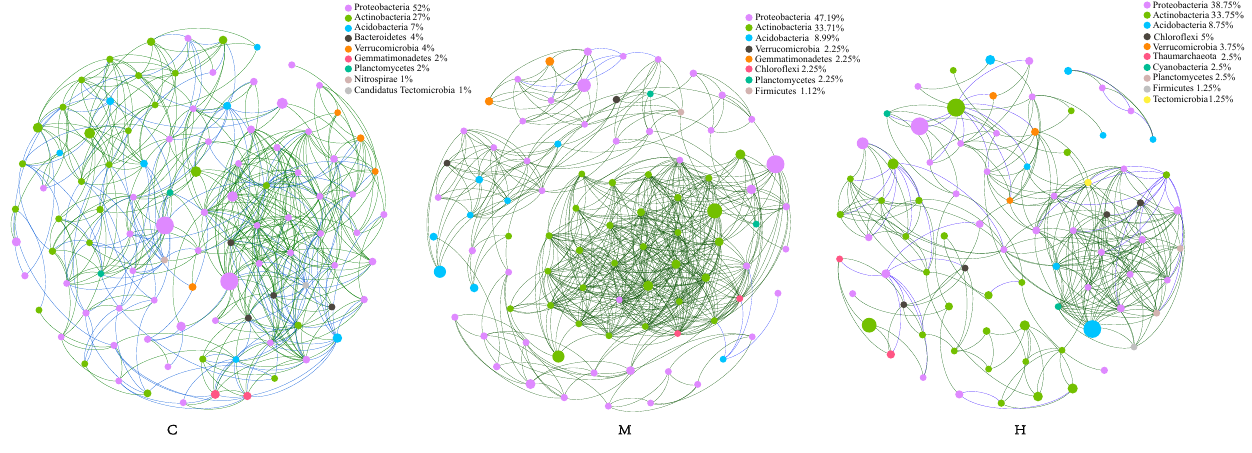
Figure 4. Community networks of C, M and H set up co-occurrence based on top 100 genera respectively. Each node represents a genus, and the size and color represent its abundance and the annotation color of the phylum which it belongs, respectively. Green line—positive correlation, blue line—negative